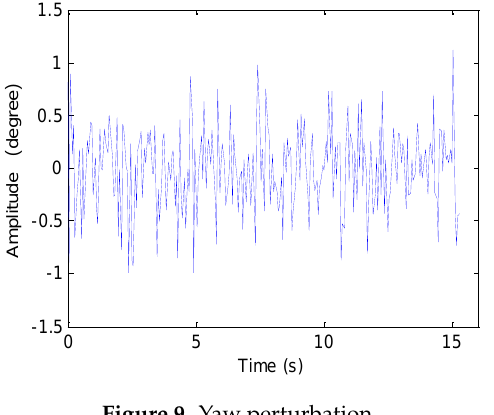
Figure 9. Yaw perturbation.